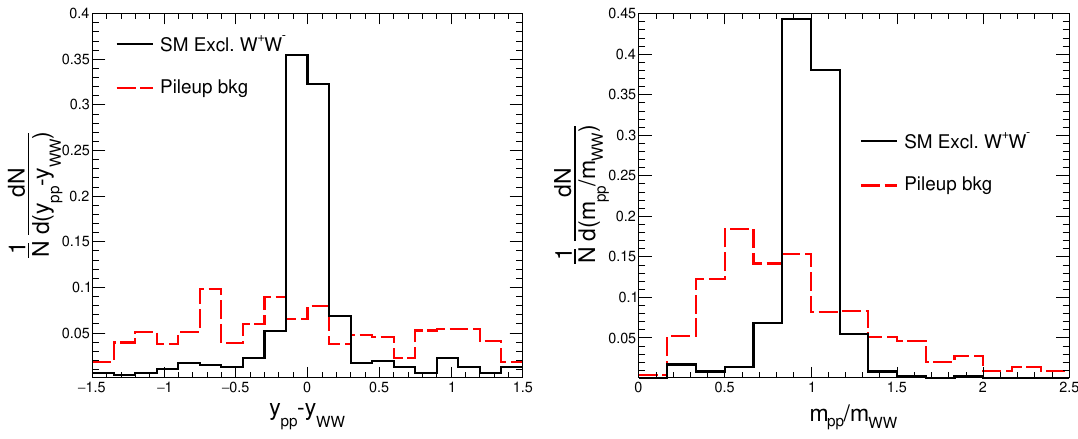
Figure 4 . Distributions of difference in rapidity y WW − y pp (left) and mass ratio m pp /m WW (right) between the W + W − and pp system for central exclusive W + W − (black solid line) and pileup background (red dashed line) to illustrate the effectiveness of the mass and rapidity matching in order to reject pileup background. The figures are plotted after the m j1 , m j2 , m WW , p j2 | φ j1 − φ j2 | selection requirements described in text. The distributions are normalized to